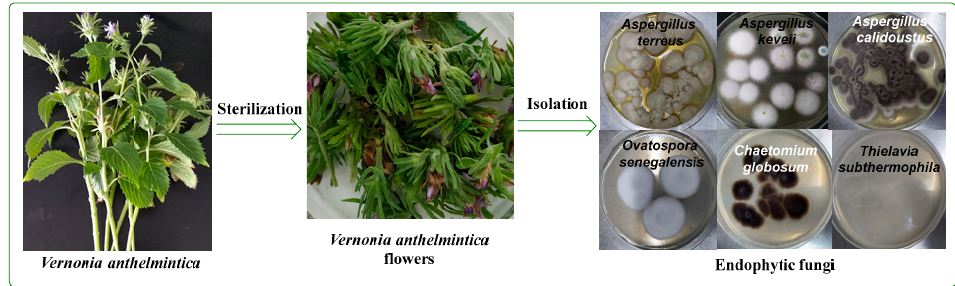
Figure 1. Isolated fungal strains from the flowers of the medicinal plant V. anthelmintica.